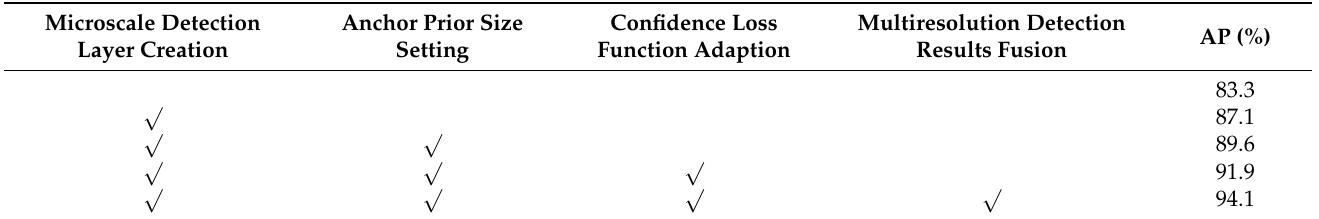
Figure 8. Positive bounding boxes and wheat spike bounding boxes of microscale detection layer ( a ), small-scale detection layer ( b ), medium-scale detection layer ( c ), and large-scale detection layer ( d ). Positive sample bounding box (blue). Wheat spike bounding box (green). Table 4. Ablation study of components of the proposed method with 600 × 600 input